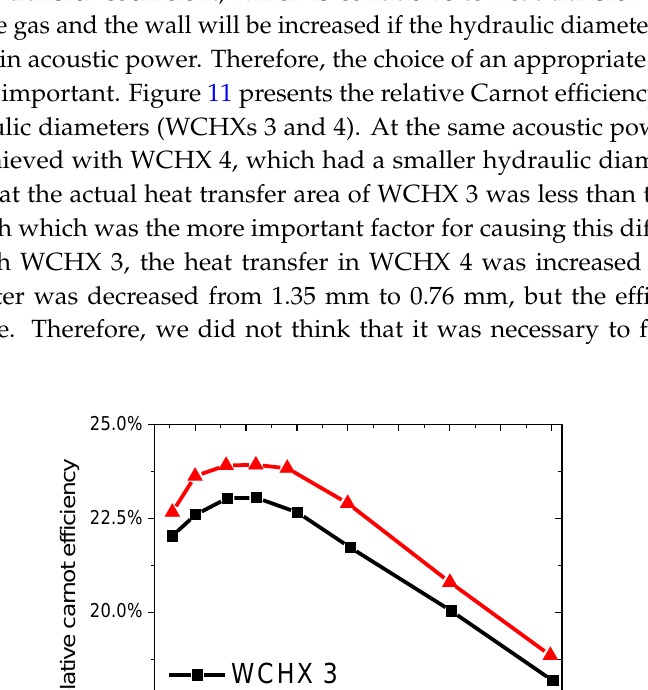
Figure 12. Dependence of relative Carnot efficiency on input acoustic power for WCHXs 4 and 7.